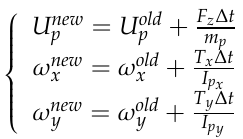
Figure 3. The 12 cross-sections along the length of the channel are used to calculate the lift forces on particles considering trilinear interpolation between these sections. Particles are dominated by the drag force in the right portion of the design after the tapered section; therefore, the effect of lift forces on particle encapsulation is negligible in this zone. Here, 𝑥 (cid:3042) stands for the local x -coordinate laid in the direction of the oriented channel, and subscript t shows the local x-coordinate of the tapered section. Since the flow rate and the shape of both cell channels are the same and the two cell types are of equal size, the lift forces on both cell types in the channel have the same magnitude. The flow profiles in every cross-section are symmetrical with respect to the xy-plane in the global coordinate. The code for calculating the lift forces is used for the points in the right side of the cross- sections. However, on the other side, the symmetry condition is implemented. The lift force in the direction of y ( F y ) in the local coordinates of the cross-sections does not vary between these halves, but ( F x ) is in the opposite direction with equal magnitude. After the cross-section at x = 190 μ m (locally